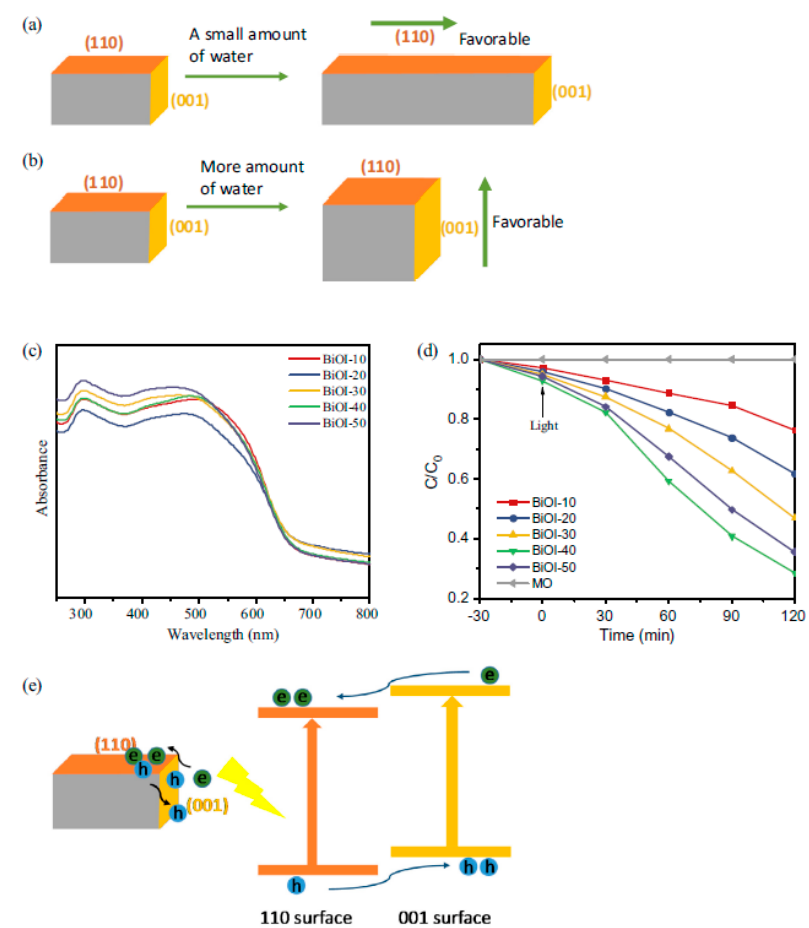
Figure 12. ( a , b ) Schematic illustrating the growth of TiO 2 nanosheets at different conditions. ( c ) UV-vis images of the related samples. ( d ) Photocatalytic degradation efficiency of different catalysts for methyl orange. ( e ) Schematic demonstrating the migration of electrons and holes in the surface heterojunction. Adapted with permission from Reference [74]. Copyright (2018) Elsevier.